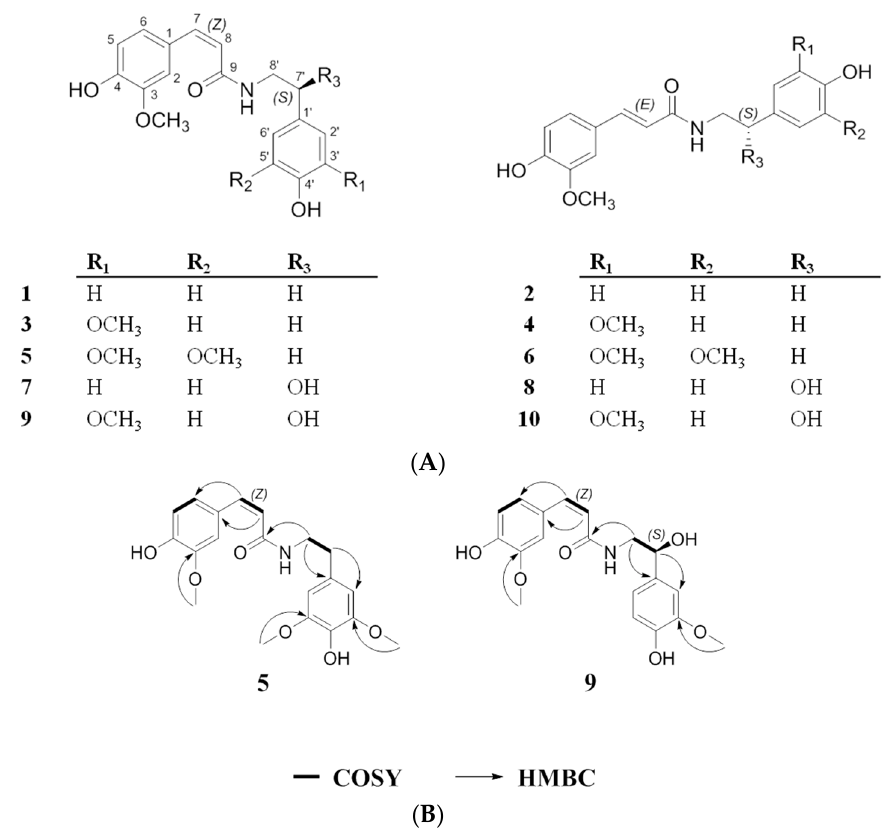
Figure 1. Structures of compounds 1 – 10 isolated from Portulaca oleracea ( A ); 1 H- 1 H COSY and HMBC correlations for compounds 5 and 9 ( B ).